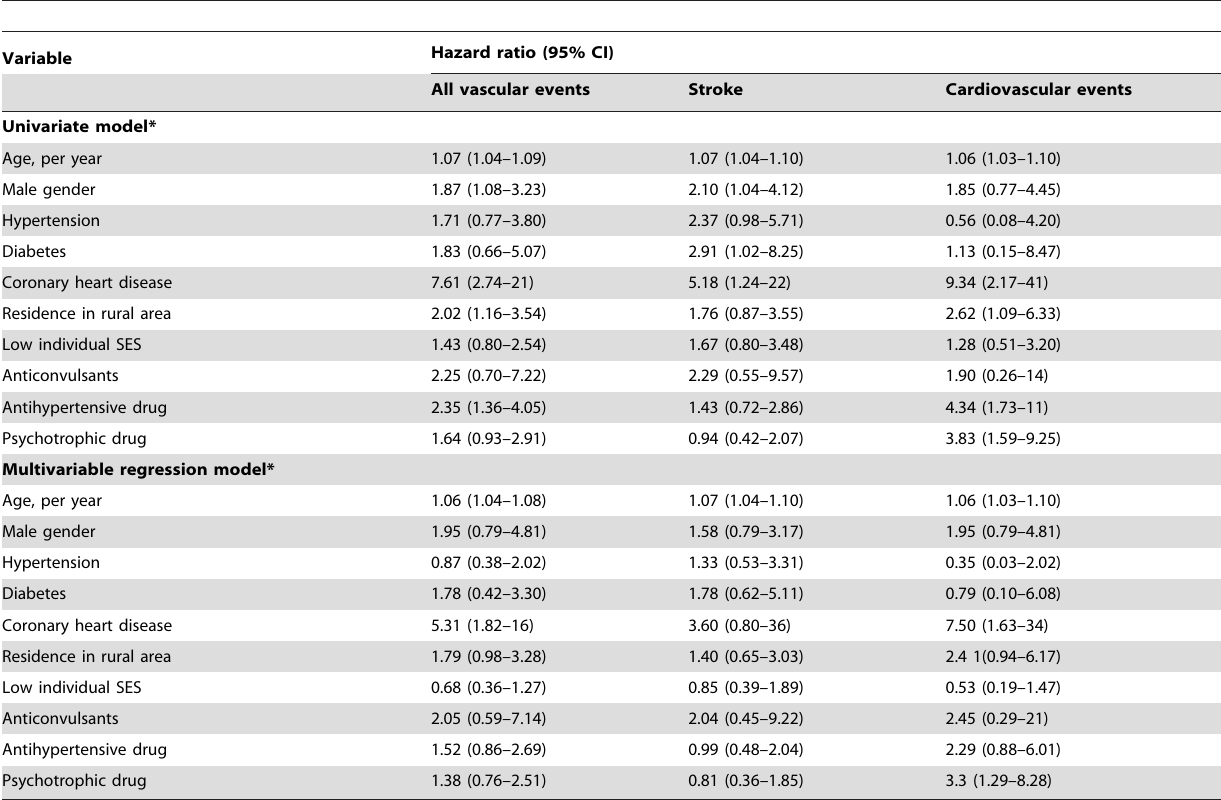
Table 5. Predictors of vascular events among ER patients discharged home with diagnosis of dizziness or vertigo (n =1118).